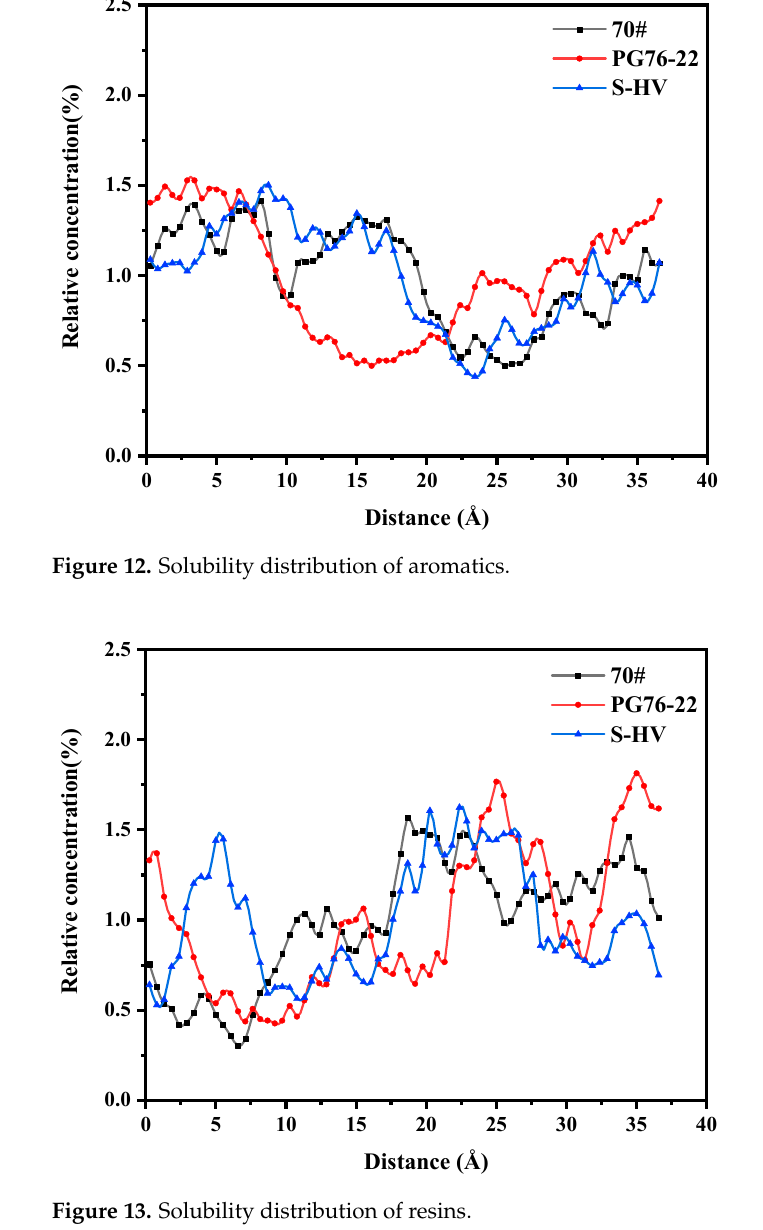
Figure 14. Solubility distribution of asphaltenes. 4. Conclusions In order to study the adsorption performance of the interface between asphalt and C- S-H gel, three types of asphalt binder and C-S-H gel models were developed by MD. The effects of different asphalt components and temperatures on the adsorption performance of asphalt–C-S-H gel interface were analyzed. The following main conclusions were drawn. (1) Adhesion work between different types of asphalt binder and C-S-H gel was in the following order: S-HV modified asphalt > PG76-22 modified asphalt > 70# asphalt, which was consistent with SBS modifier content. Adhesion work was mainly provided by Coulomb electrostatic force and the electrostatic interaction between asphalt and C-S-H gel surface was increased by the increase in temperature.